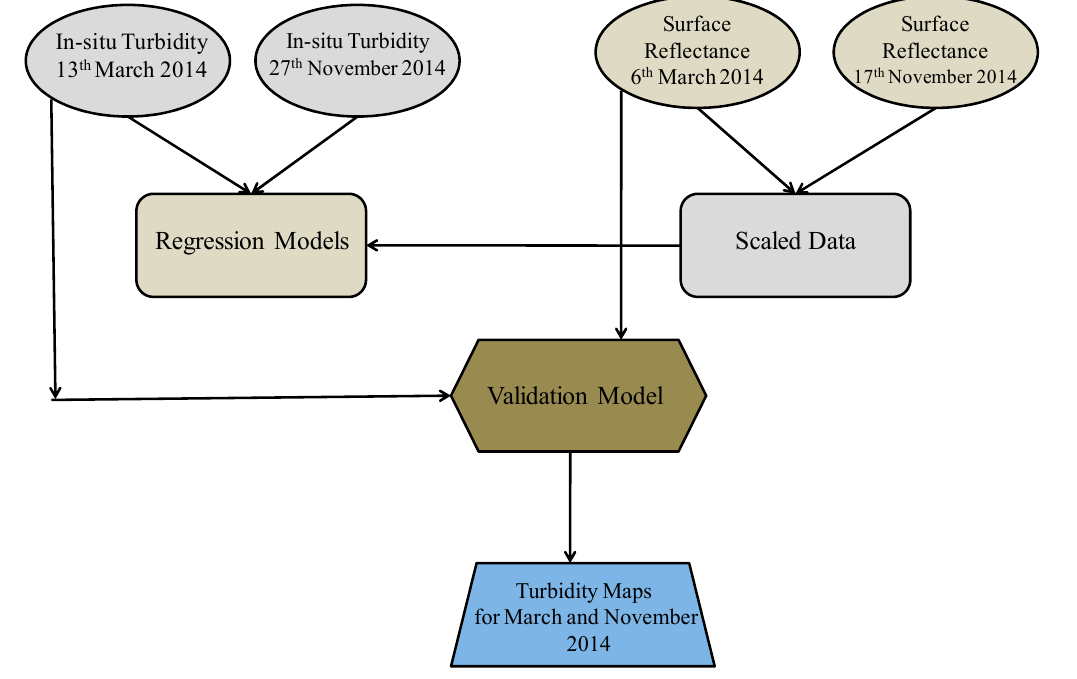
Figure 5. Flow chart summarizing the approaches followed.